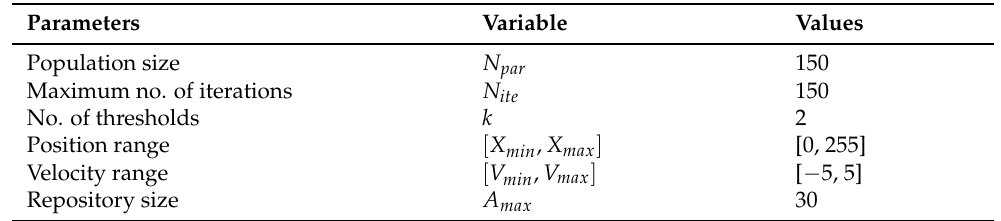
Table 3. MMPSO parameter